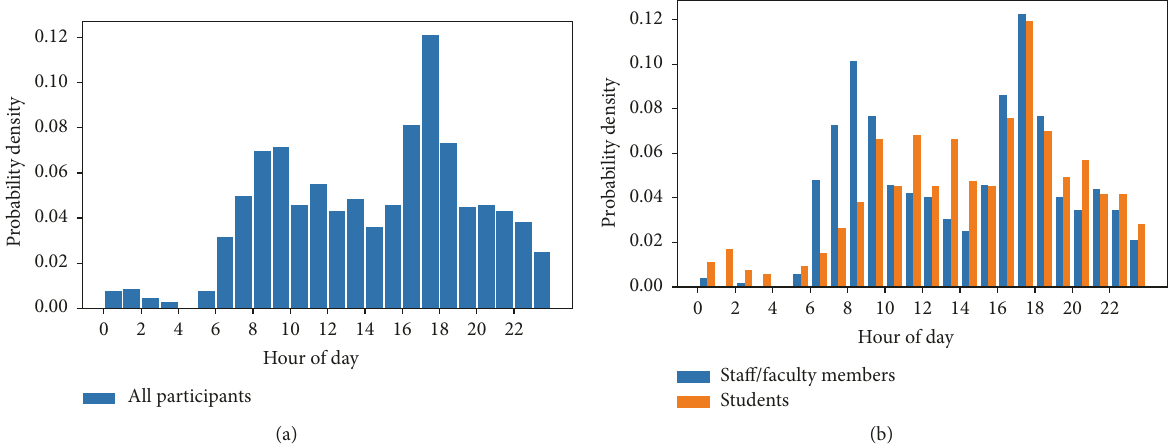
Figure 5: Probability distribution of the start of a charge cycle on an hour-of-day scale (a) for all participants, (b) split by occupation.